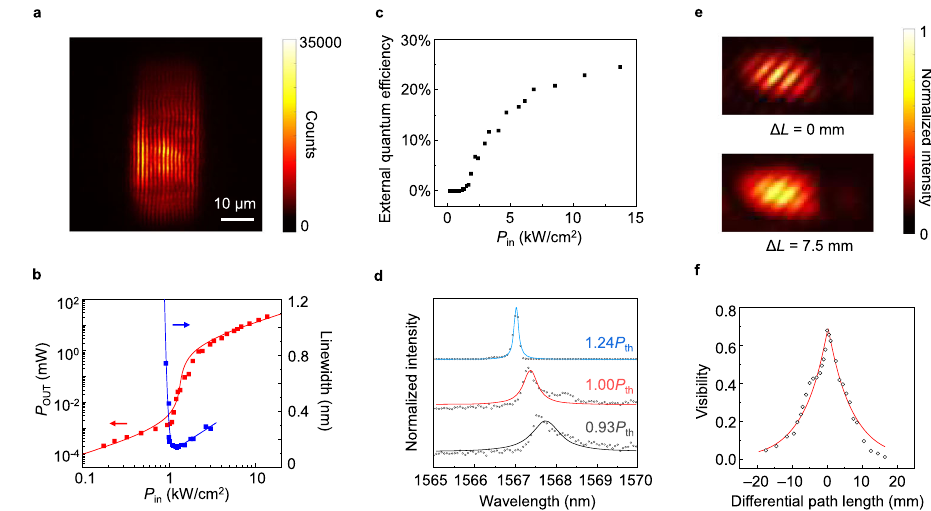
Fig. 4 | Threshold behavior in light-light and linewidth evolution curves. a Experimentalemissionpatternsinrealspace. b Light-lightcurveofthedevice inlog-logscaletogetherwiththelinewidthevolutioncurveundervaried pump power. c External quantum ef fi ciency of the device under varied pump power. d Spectra around threshold. Circles: data; lines: fi tting. e Interference patterns by superposing two split lasing emission beams at two different differential